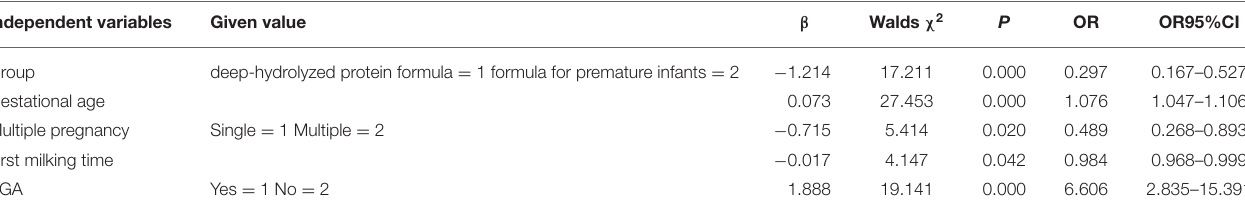
TABLE 4 | Logistic regression analysis of FI risk